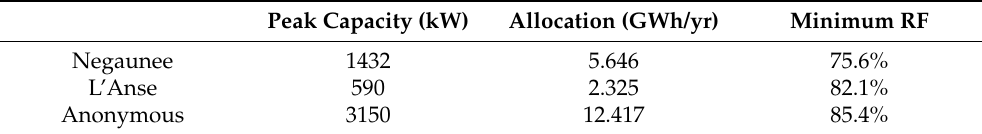
Table 4. The proportions of hydropower capacity, supply, and cost for each location. Peak Capacity